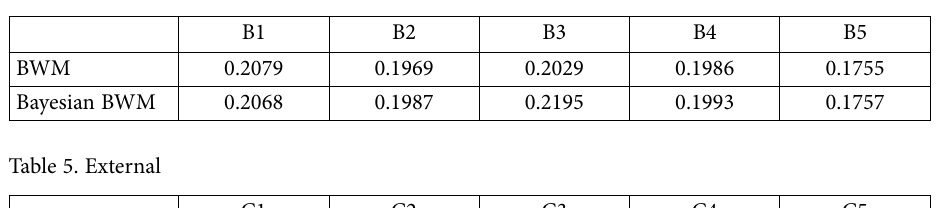
Table 4. Inter-organizational